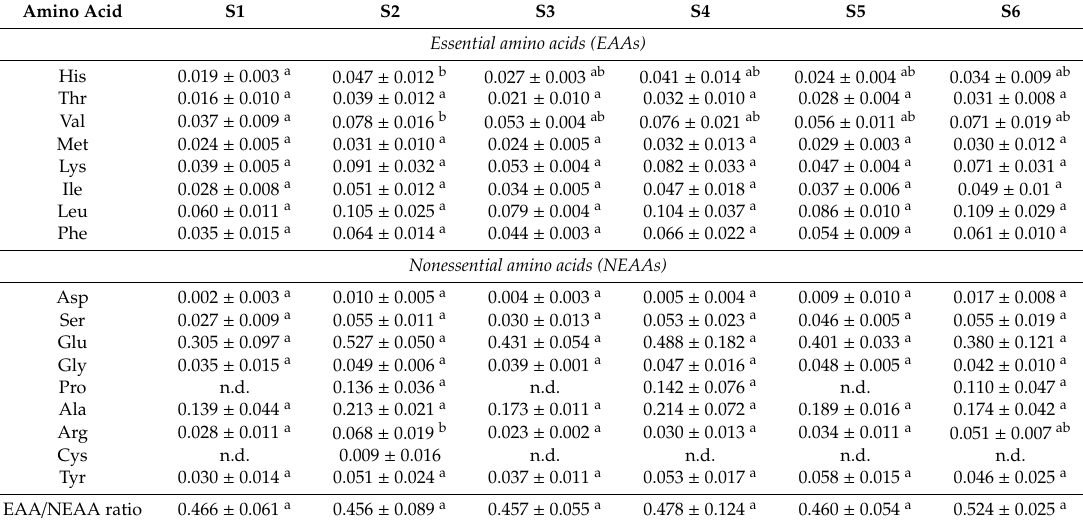
Table 2. Protein digestibility (%) from sous vide beef steak after hydrolysis with gastrointestinal enzymes.